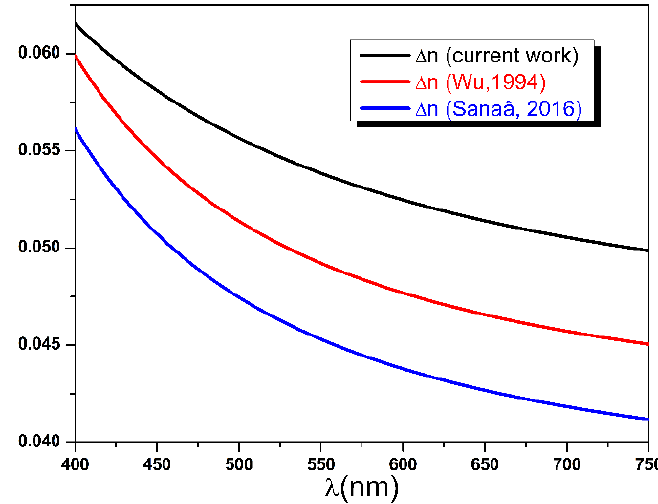
Figure 11. Birefringence dispersion curves in the range (400, 750 nm) compared with previous experimental results [1,2].